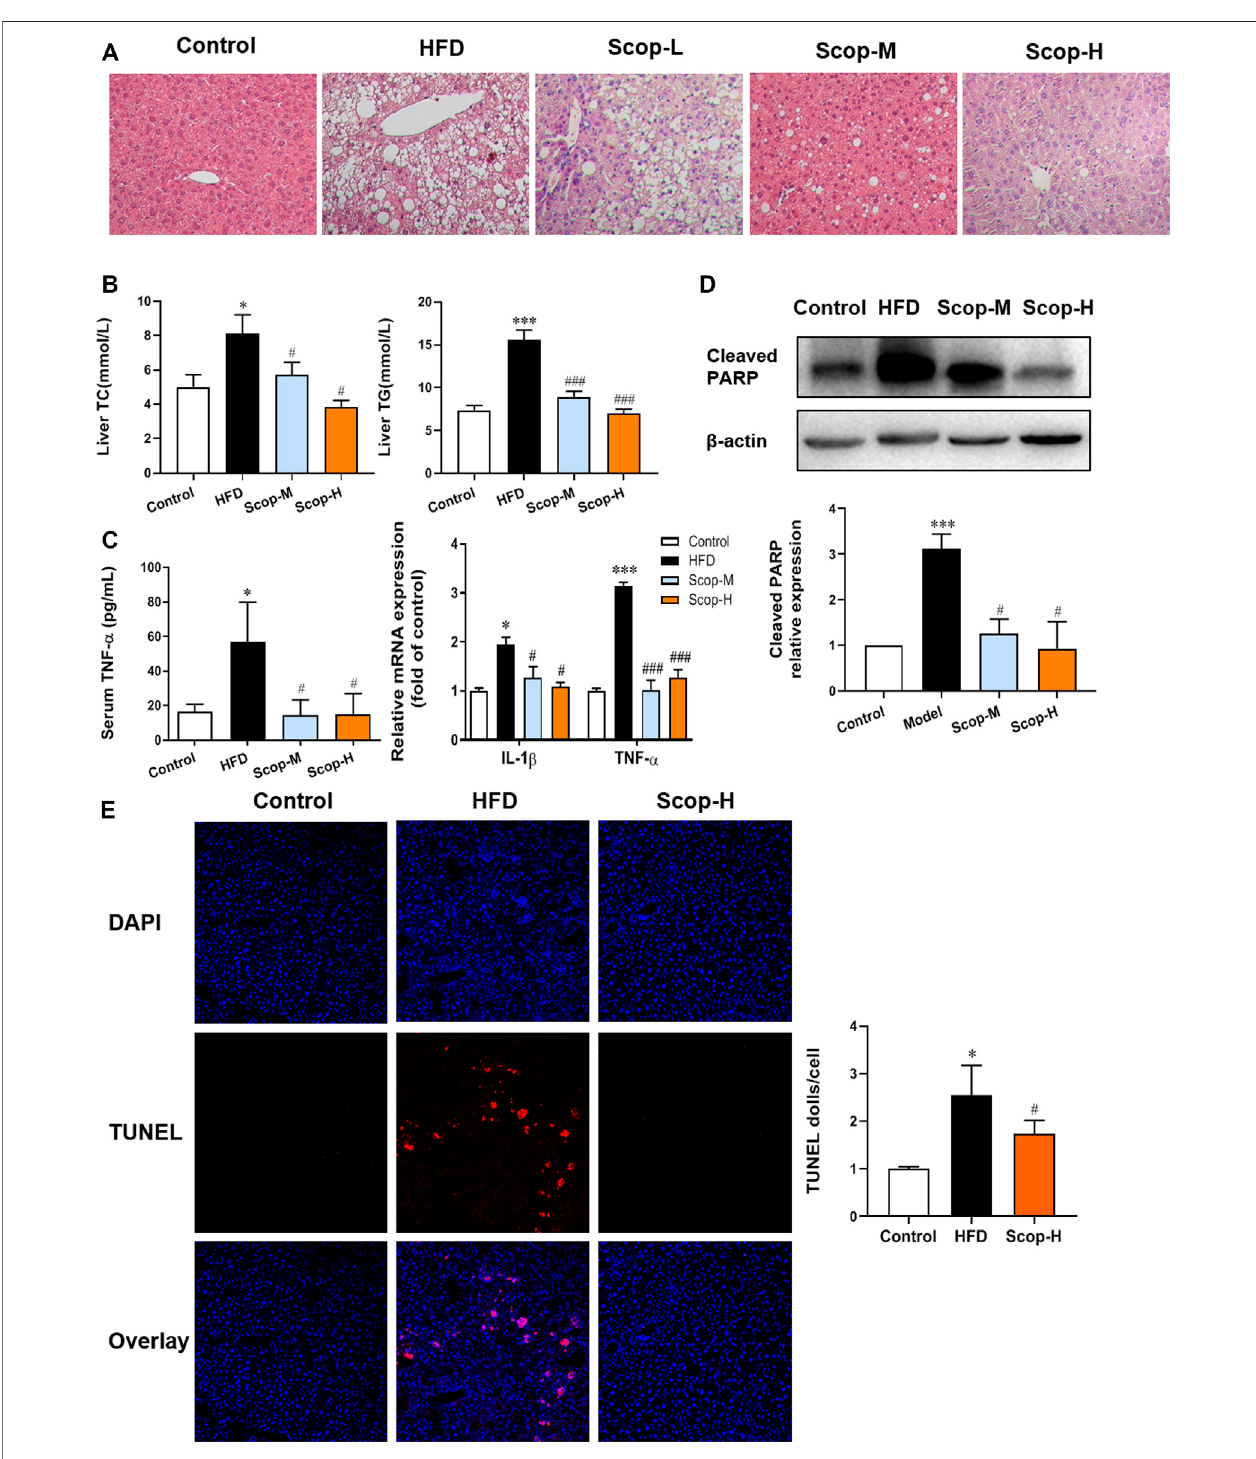
FIGURE7| ScoparonereducedthelipotoxicliverinjuryintheHFD-inducedNASHmice. (A) HEstainingofmouselivertissues(200×). (B) TheTGandTCcontentof mouse liver tissues. (C) Serum TNF- α level and IL-1 β , TNF- α mRNA expression of liver tissues. (D) Cleaved PARP protein expression in mouse liver tissues. (E) TUNEL staining of mouse liver tissues (200×). * p < 0.05, *** p < 0.001 vs. Control; # p < 0.05 , ### p < 0.001 vs. Model.